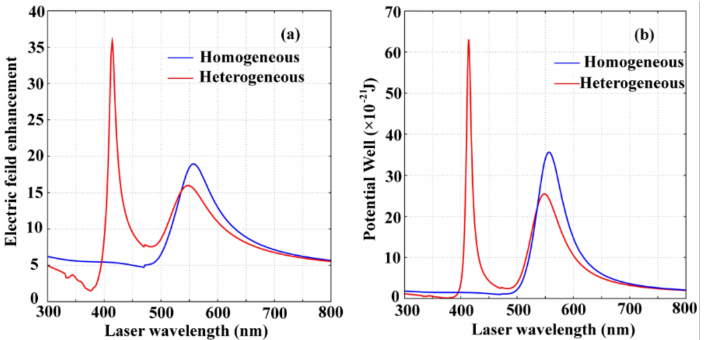
Figure 4. The electric-field enhancement spectra ( a ) and wavelength-dependent plasmonic potential well ( b ) for the homogeneous Au–Au and heterogeneous Au–Ag dimers. The bowtie edge length is 20 nm, the bowtie gap is taken as 10 nm.